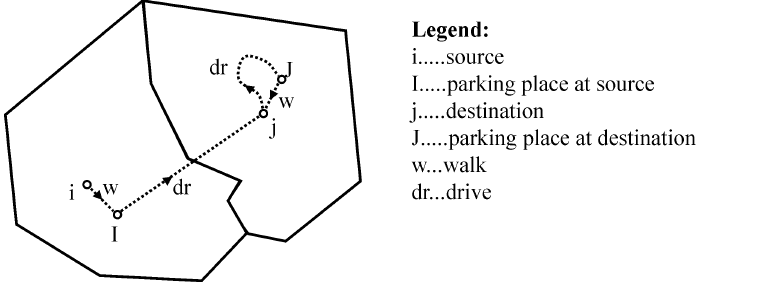
Figure 12: Components of a car trip from source i to destination j in the